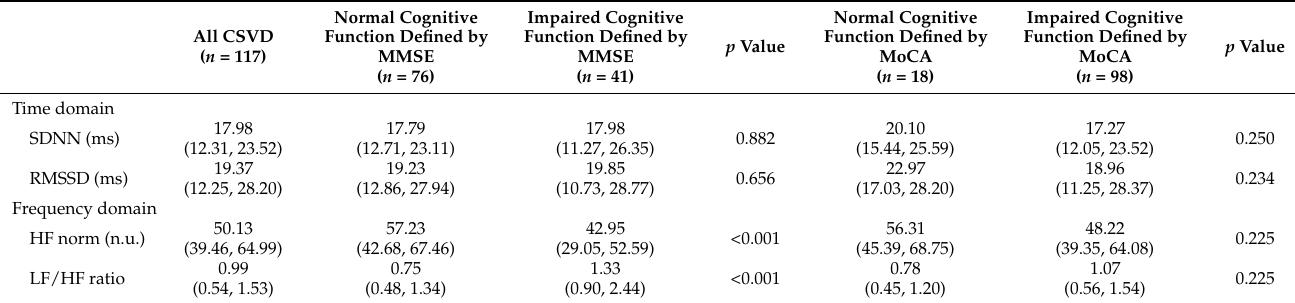
Table 2. HRV parameters of patients with CSVD [Median (Q1, Q3)].